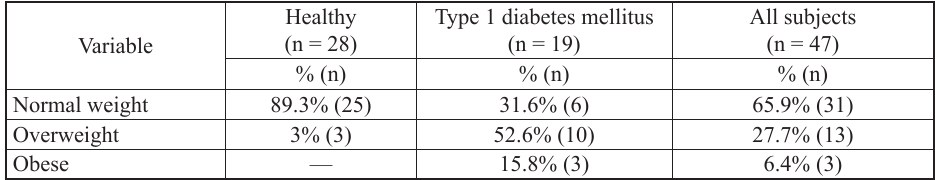
Table 2. The effect of a 7-day physical program: aerobics (AE) and swim- ming (SW) on the blood glucose level (mmol / l) in healthy girls and girls with type 1 diabetes mel-